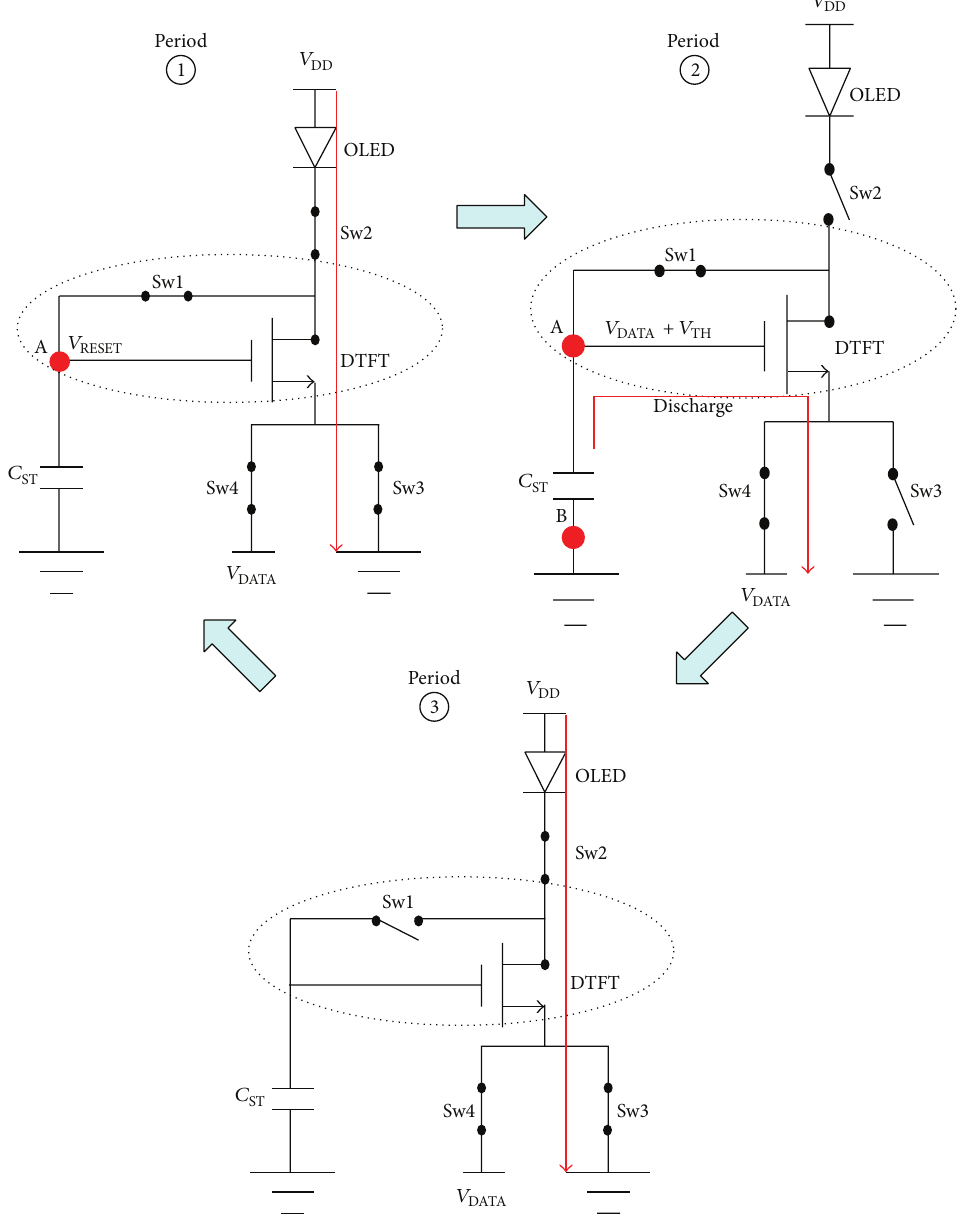
Figure 3: Equivalent circuits at each operation stage.